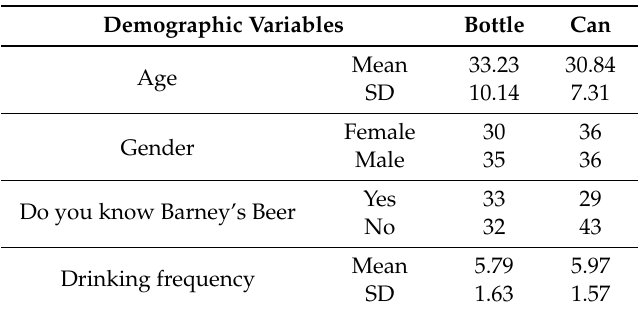
Table 2. Descriptive statistics for the demographic variables of the participants in the groups drink the beer that had been poured from the bottles and cans, respectively.